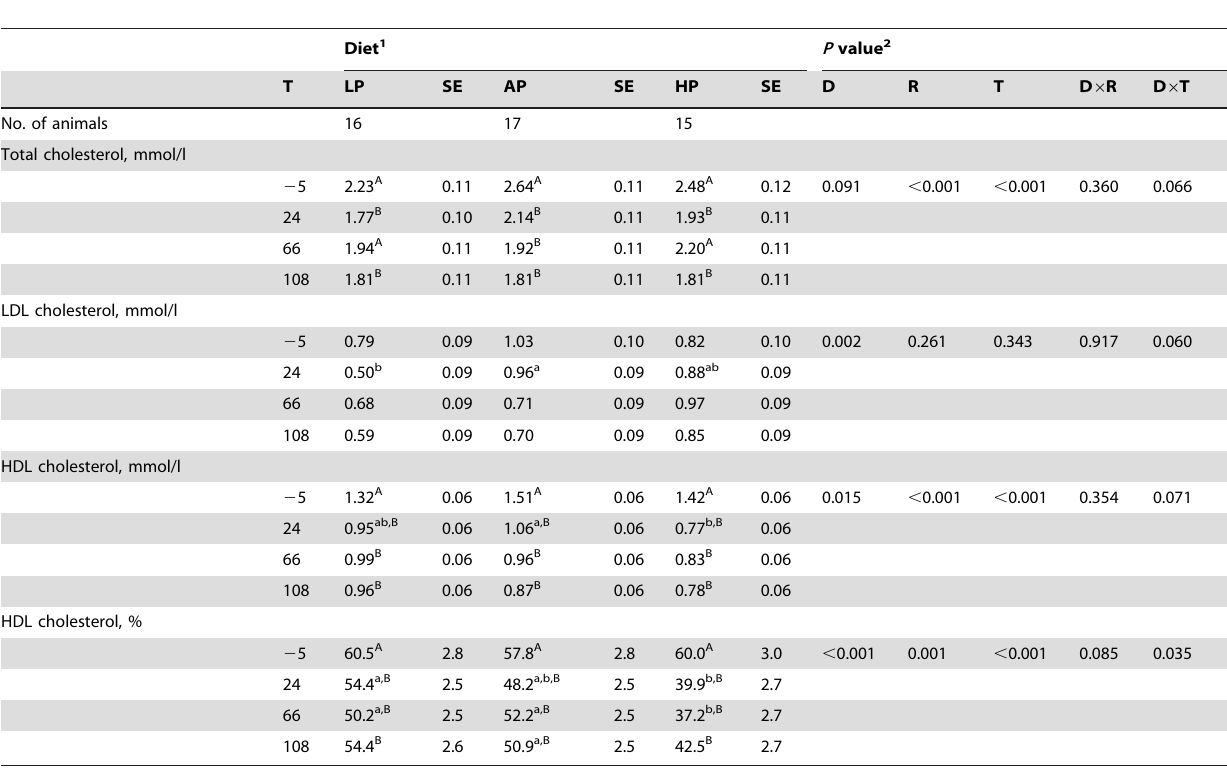
Sows were fed isoenergetic diets with low protein:high carbohydrate (6.5% crude protein, LP), adequate protein:carbohydrate (12.1% crude protein, AP), and high protein:low carbohydrate (30% crude protein, HP) ratios throughout pregnancy (EXP1). a–c Within a row, values not sharing a common superscript differ significantly ( P , 0.05) according to Tukey post hoc test. A–C Within diet and variable, values not sharing a common superscript differ significantly ( P , 0.05) according to Tukey post hoc